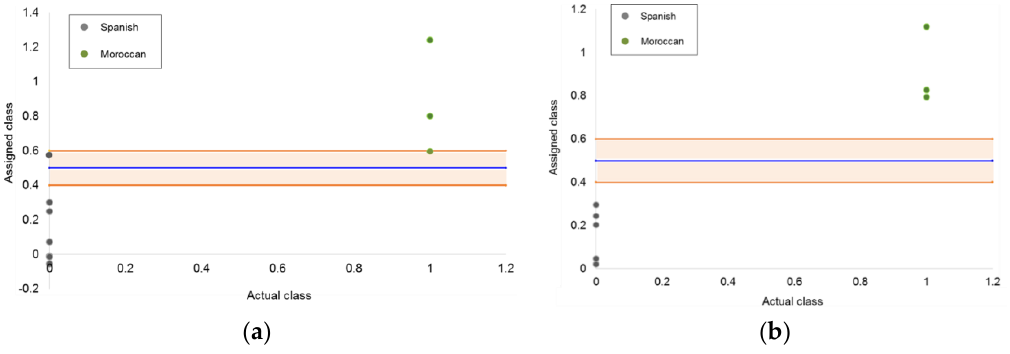
Figure 4. Classification plot of the partial least squares-discriminant analysis (PLS-DA) models from liquid chromatography (LC) data obtained in ( a ) normal phase and ( b ) reverse phase at 210 nm. The orange area represents the inconclusive area. Table 6. PLS-DA classification results for the validation set.